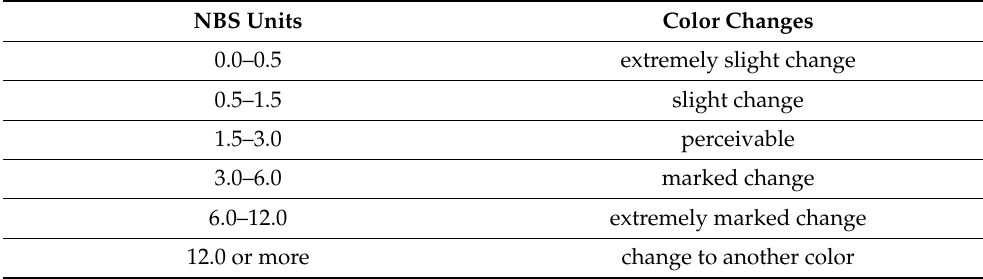
Table 3. Levels of color change, according to